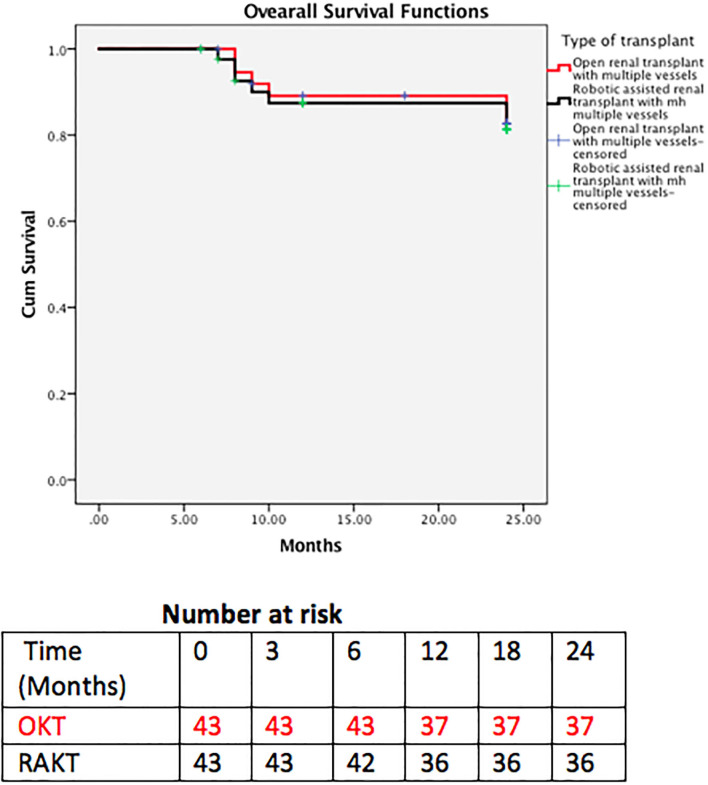
Overall survival.